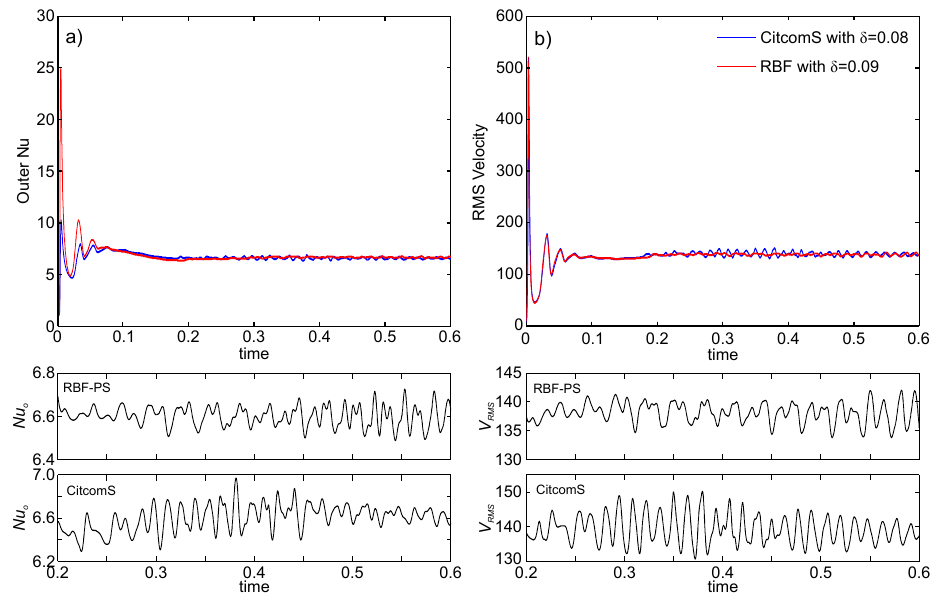
Figure 5. Time trace of (a) the outer Nusselt number and (b) the rms velocity for both models at Ra = 70000 for Ra = 70000 and δ = 0 . 08 with CitcomS and δ = 0 . 09 with RBF. Both methods converge to an unsteady oscillating axisymmetric pattern dominated by the ‘ = 2 mode (see Fig.